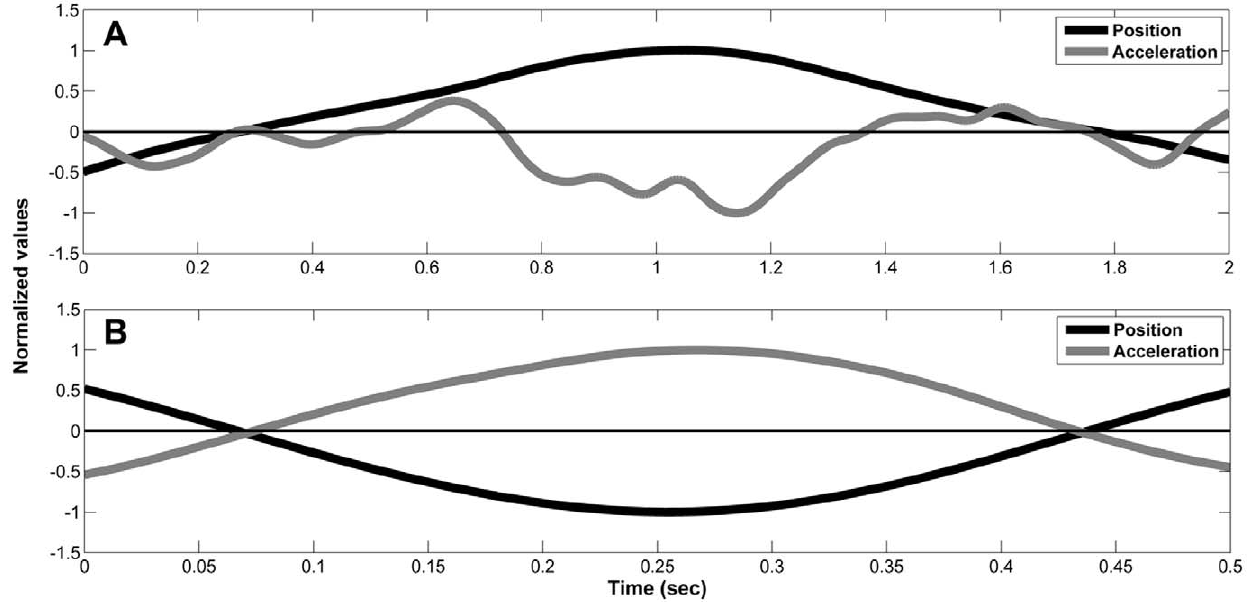
Figure 4. The computation of harmonicity (H). The computation of harmonicity (H) is portrayed for a discrete movement, for which H=0, in (A) and for a rhythmic movement, for which H=1, in (B). In both plots, the black line corresponds to position trace of a single half-cycle of movement around a reversal and the gray line corresponds to the acceleration trace.